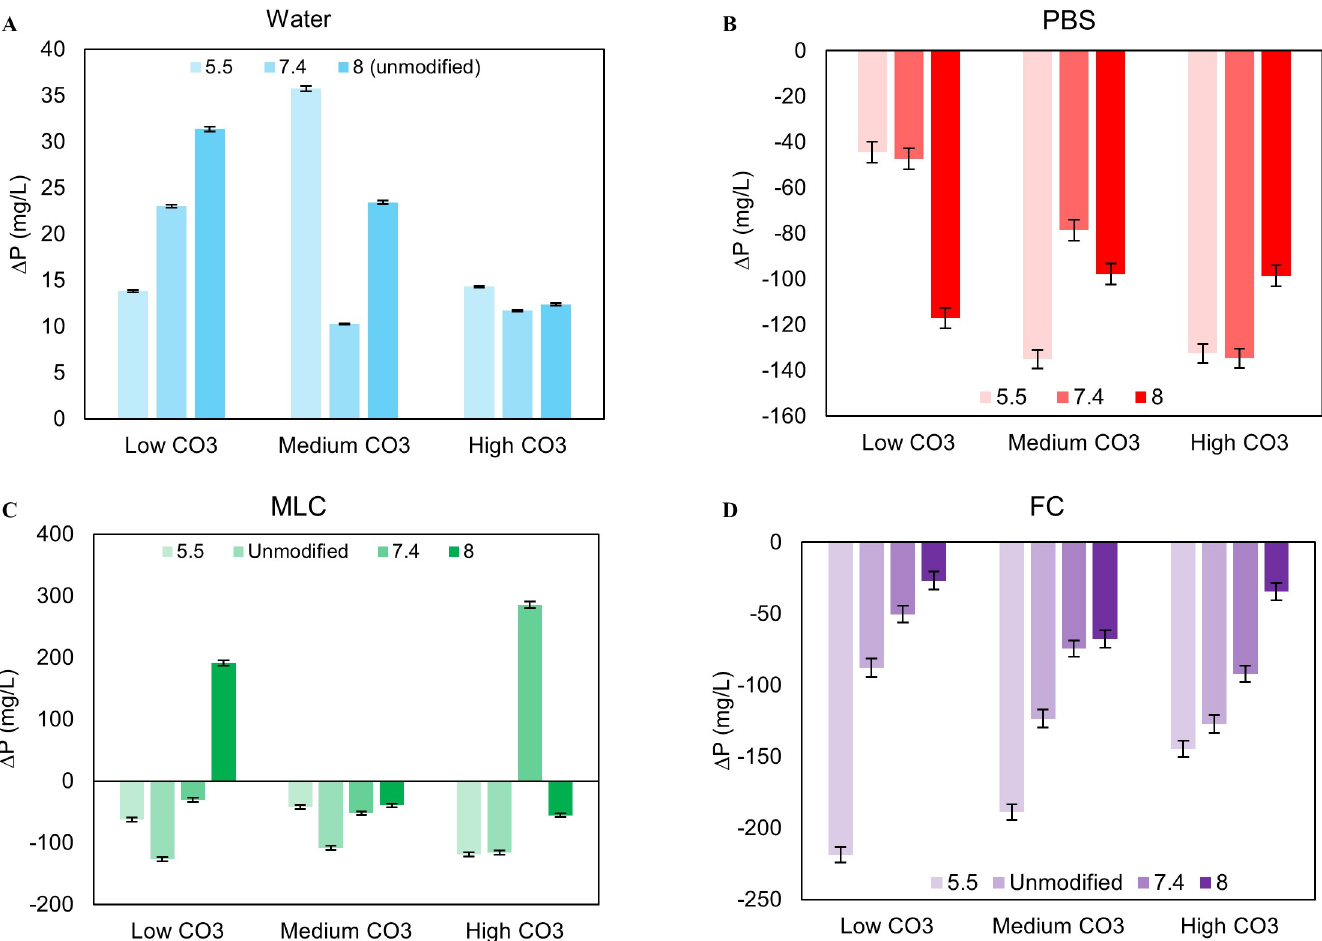
Fig 2. Change in phosphorus amounts in the solution after exposure. P decreased in all solutions except water, indicating an uptake of phosphorus in the apatite during recrystallization (A-D) . There are no apparent trends in PBS and MLC (B, C) . In FC, P decreased in the solution as initial pH i decreased (D) . P increased in water due to the non-detectable levels of the initial solution (A)